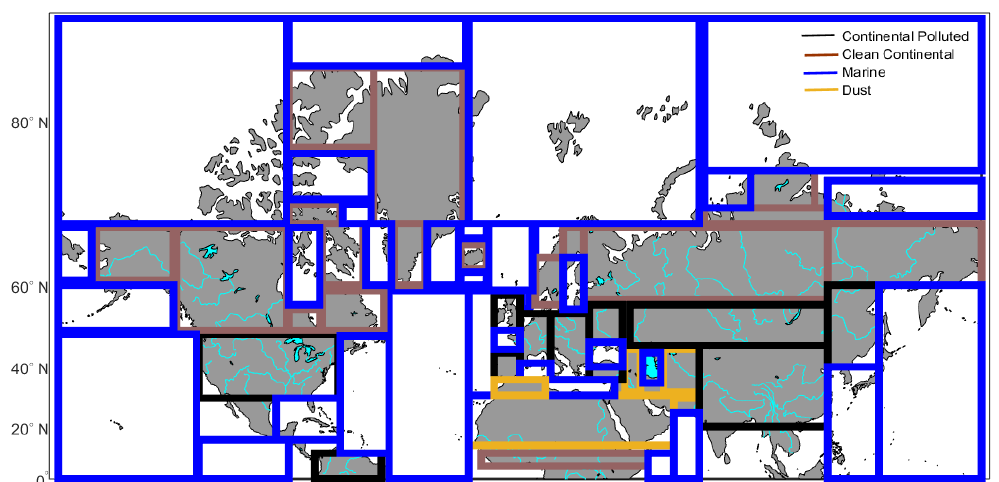
Figure 1. SCAN’s aerosol source type classification map. Different colored squares represent different aerosol sources: orange squares correspond to dust, blue squares to marine, brown squares to clean continental, and black squares to continental polluted aerosol sources.